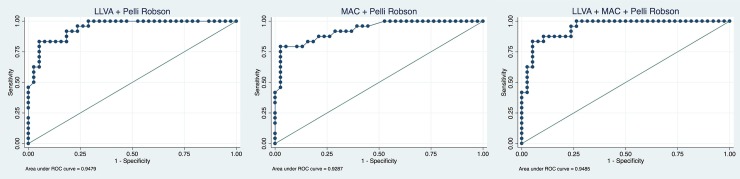
Combined ROC curves.